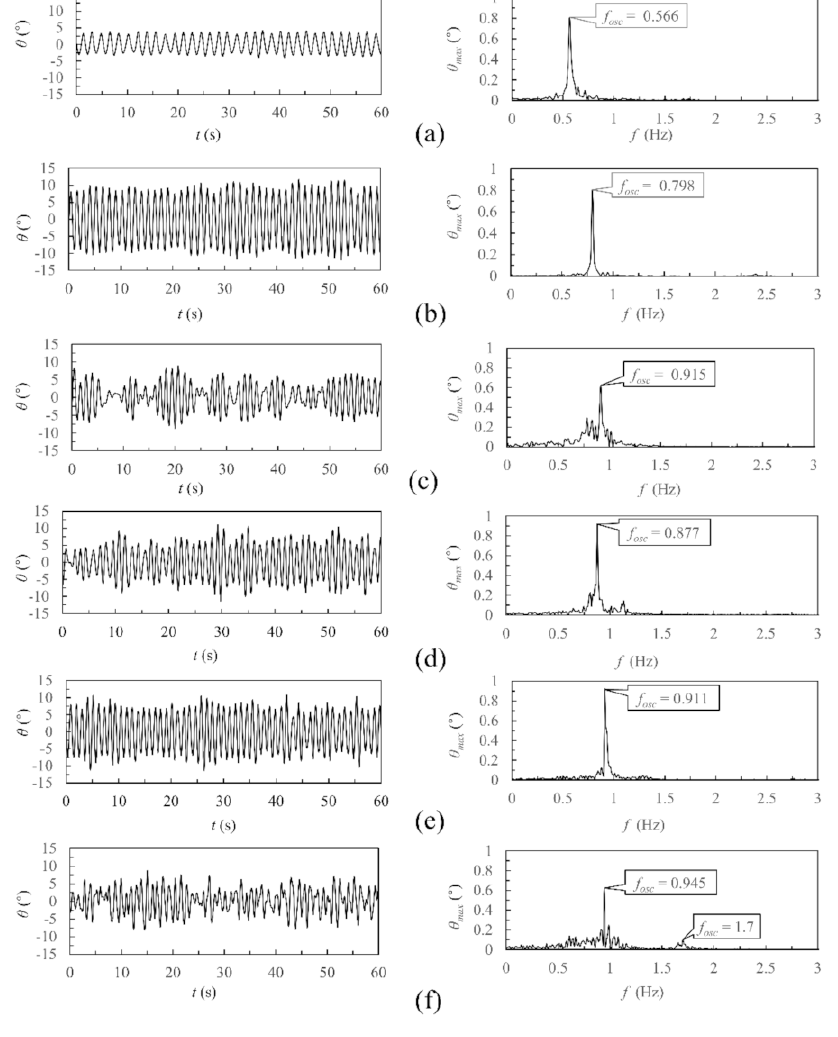
Figure 12. Rotational oscillation time history and spectral characteristics at six typical velocities when L / D = 4.0: ( a ) U = 0.302m/s ( U r = 2.631); ( b ) U = 0.483 m/s ( U r = 4.215); ( c ) U = 0.519 m/s ( U r = 4.531); ( d ) U = 0.592 m/s ( U r = 5.165); ( e ) U = 0.665 m/s ( U r = 5.798); ( f ) U = 0.882m/s ( U r =